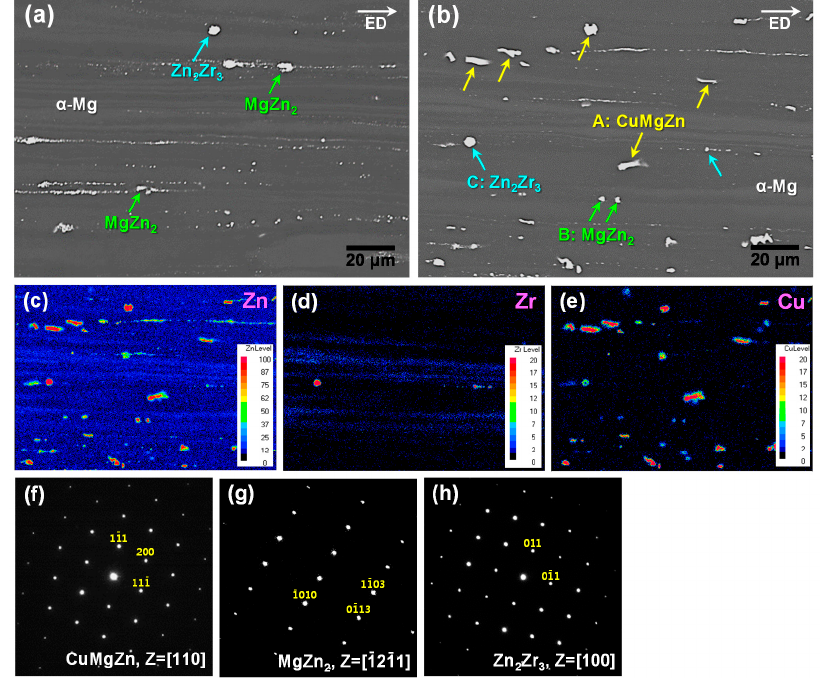
Figure 1. Scanning electron microscopy (SEM) micrographs of the extruded ( a ) ZK60 and ( b ) ZKC601 alloys; the energy probe microanalysis maps obtained from the ZKC601 alloy for ( c ) Zn, ( d ) Zr and ( e ) Cu; and electron beam diffraction patterns from ( f ) CuMgZn, ( g ) MgZn 2 and ( h ) Zn 2 Zr 3 in the ZKC601 alloy.